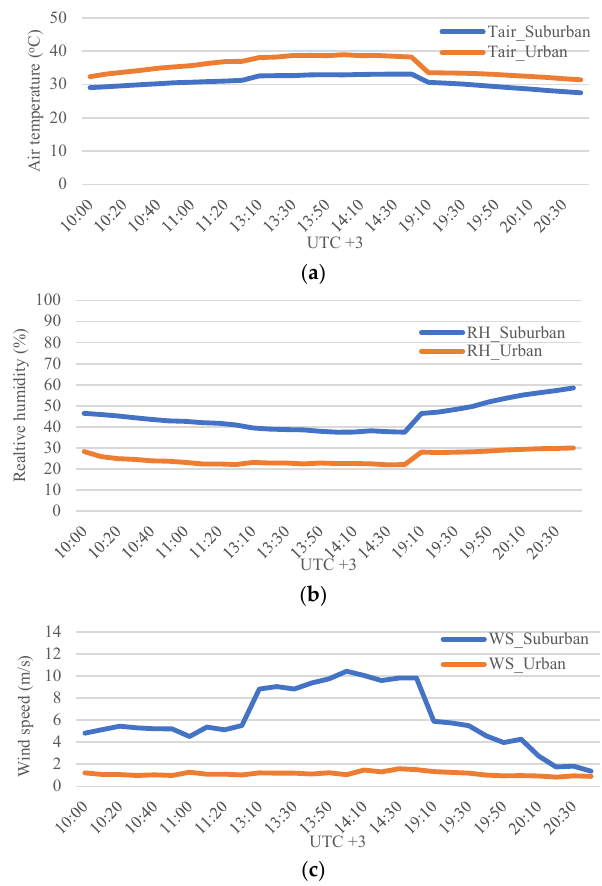
Figure 3. ( a ) Average trend of air temperature in both urban and rural area. ( b ) Average trend of relative humidity in both urban and rural area. ( c ) Average trend of wind speed in both urban and rural area. Table 7. Average value of microclimatic data (16 July 2016 to 6 August 2016).